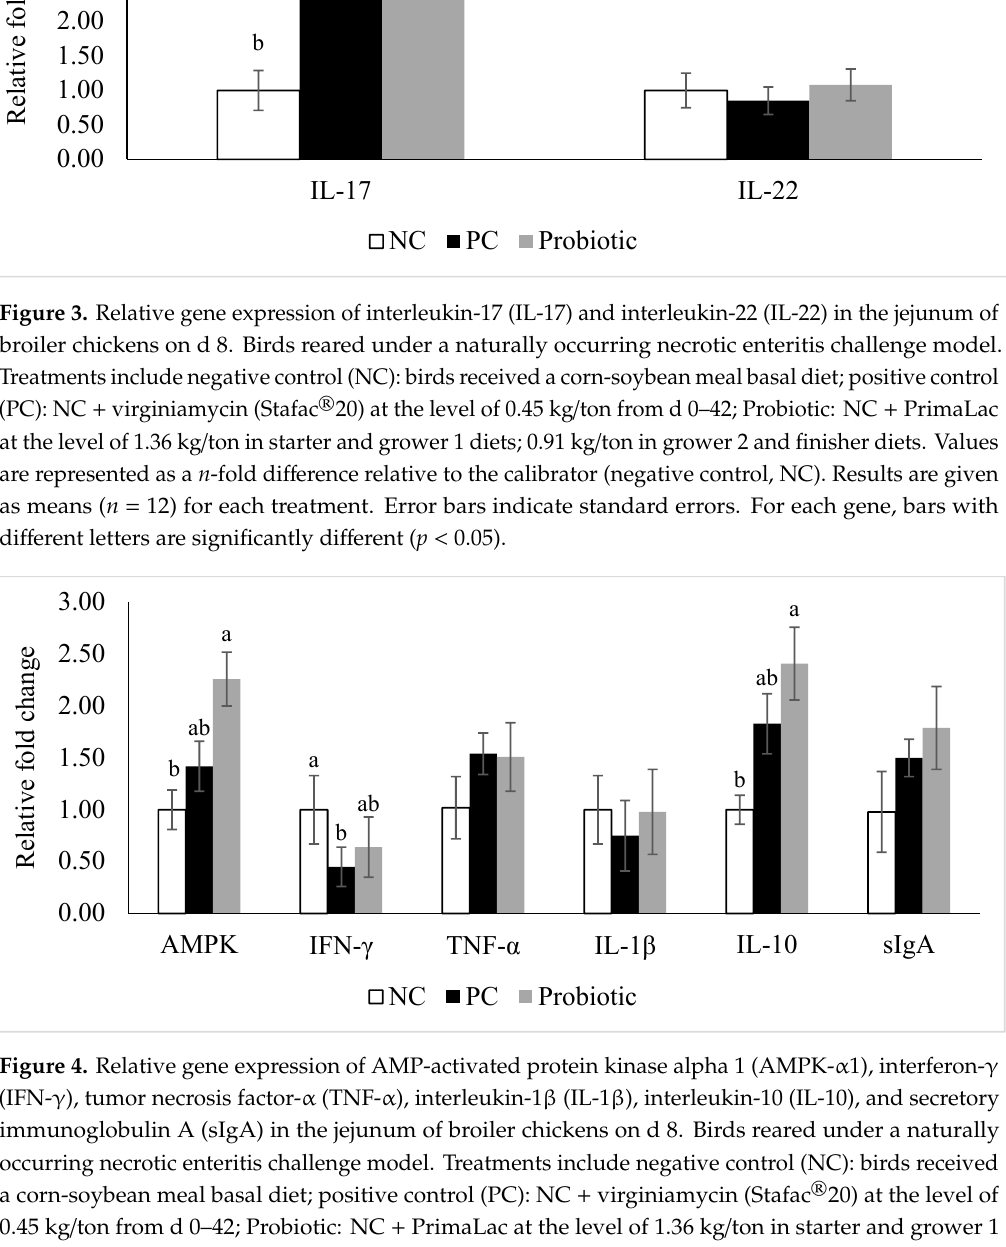
Figure 4. Relative gene expression of AMP-activated protein kinase alpha 1 (AMPK- α 1), interferon- γ (IFN- γ ), tumor necrosis factor- α (TNF- α ), interleukin-1 β (IL-1 β ), interleukin-10 (IL-10), and secretory immunoglobulin A (sIgA) in the jejunum of broiler chickens on d 8. Birds reared under a naturally occurring necrotic enteritis challenge model. Treatments include negative control (NC): birds received a corn-soybean meal basal diet; positive control (PC): NC + virginiamycin (Stafac ® 20) at the level of 0.45 kg / ton from d 0–42; Probiotic: NC + PrimaLac at the level of 1.36 kg / ton in starter and grower 1 diets; 0.91 kg / ton in grower 2 and finisher diets. Values are represented as a n -fold di ff erence relative to the calibrator (negative control, NC). Results are given as means ( n = 12) for each treatment. Error bars indicate standard errors. For each gene, bars with di ff erent letters are significantly di ff erent ( p < 0.05).